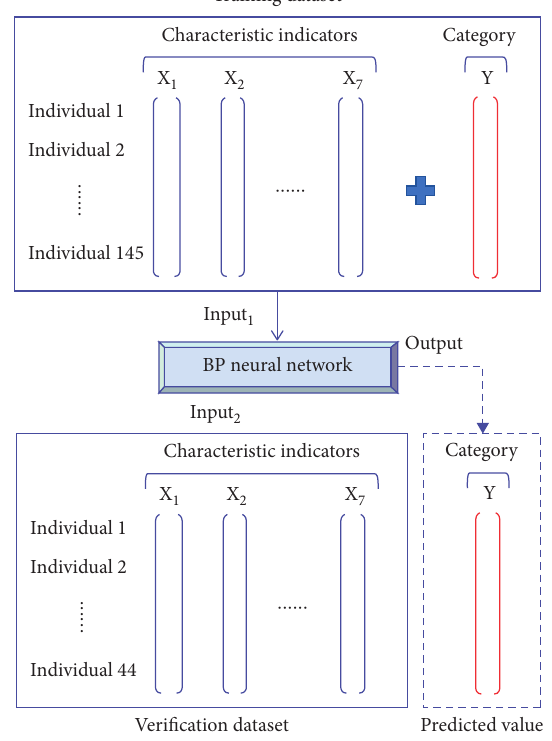
Figure 9: Feature set processing framework for PT commuter